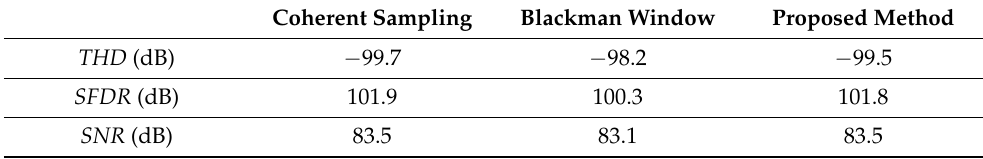
Table 3. The THD , SFDR , and SNR values were obtained under coherent and incoherent sampling.